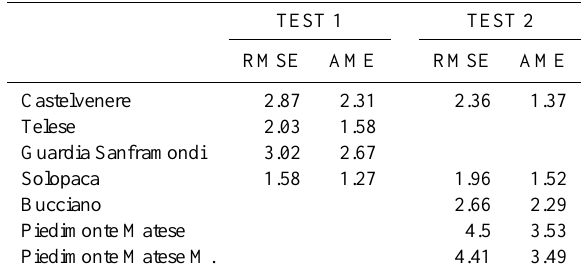
Table 11. Test 1 and Test 2 RMSE and AME statististics using five- day mean T a (values in